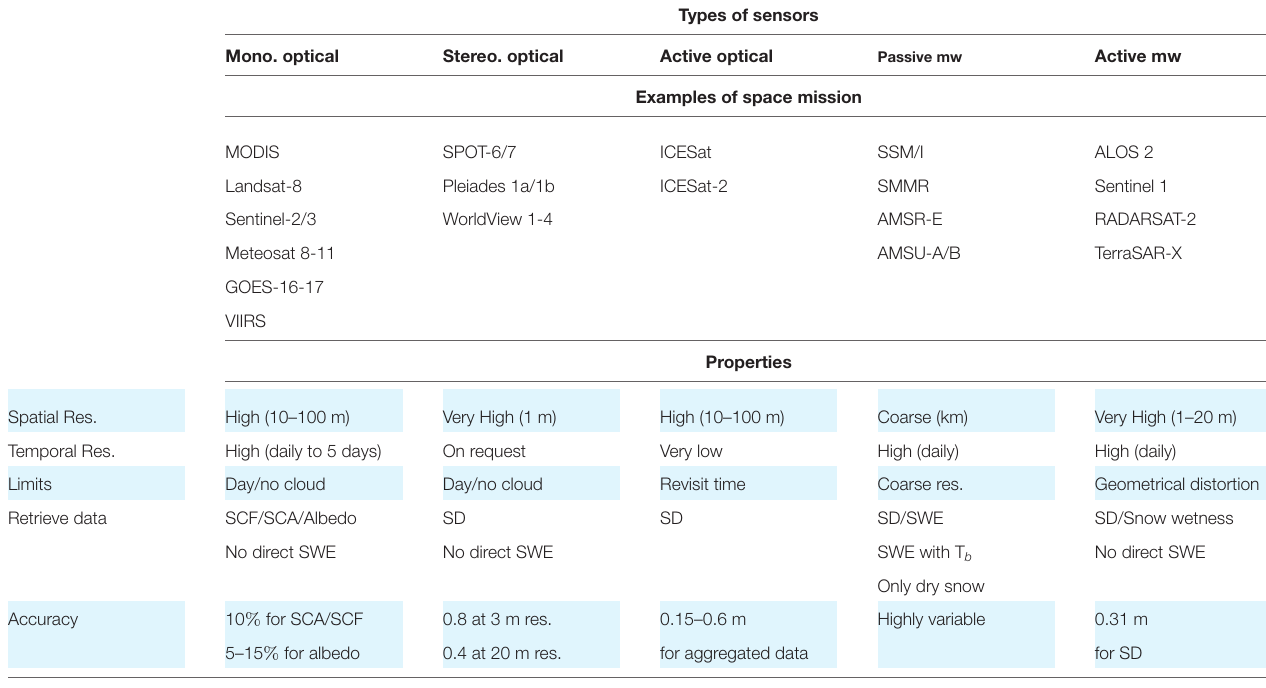
TABLE 1 | List of satellite/sensor data used in snow cover studies and their related properties classified by satellite category.